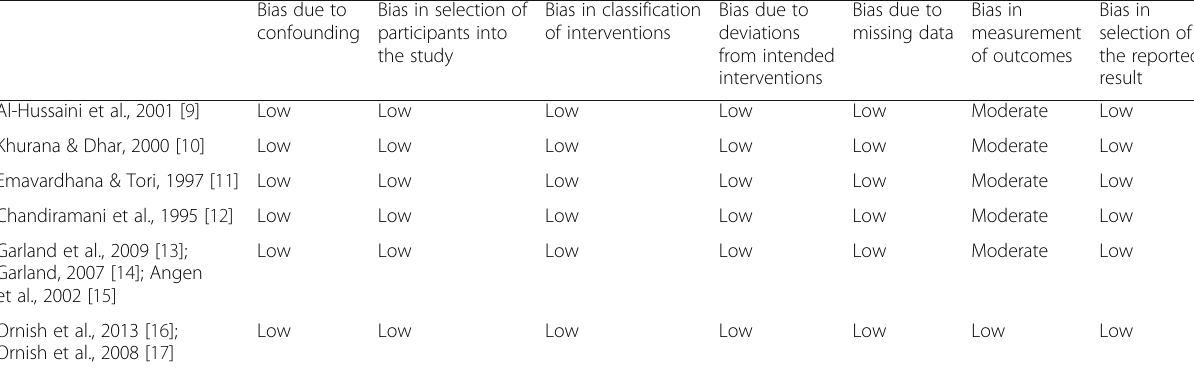
Table 5 Risk of bias summary for Non-Randomised Controlled Trial Studies